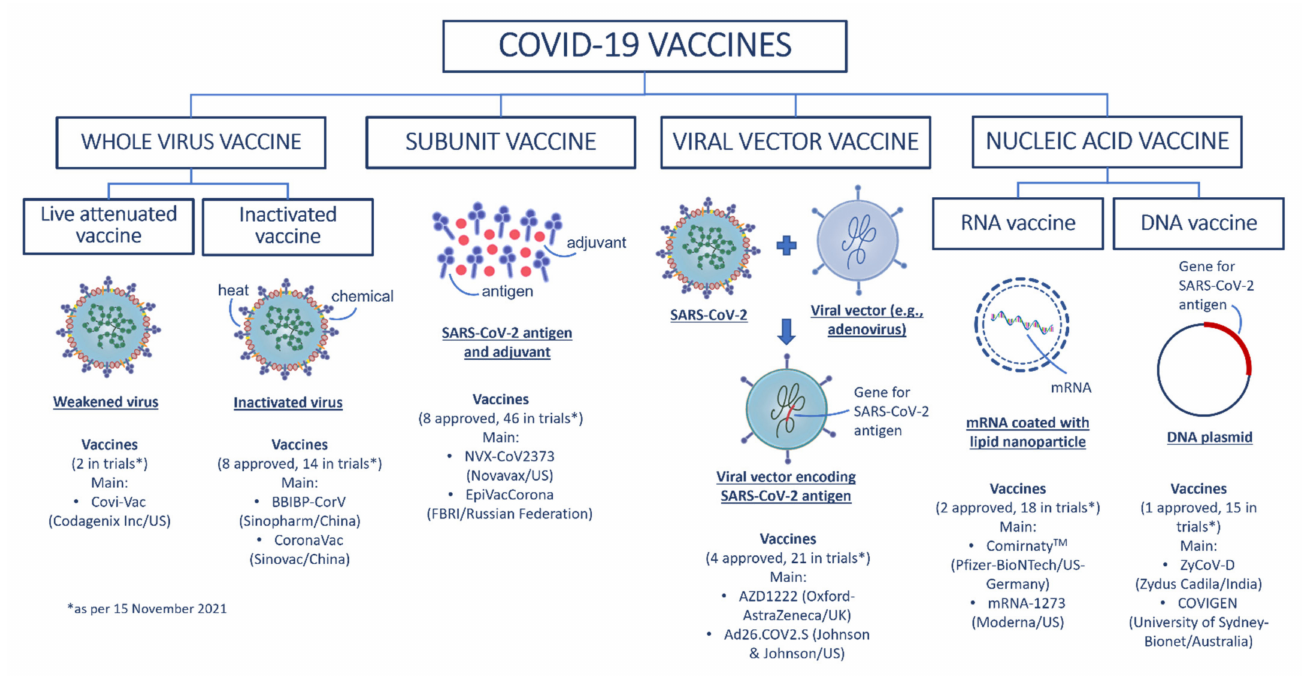
Figure 3. Schematic summary of the four broad groups of COVID-19 vaccines with examples of current COVID-19 vaccines. (Redrawn by the authors based on second figure in Ref.